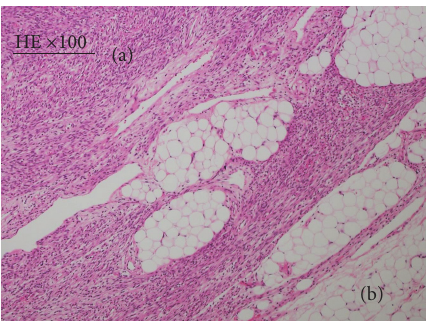
Figure 4: Hematoxylin and eosin (HE) staining findings in Case 2 ( × 100). (a) Plump to thin spindle cells with a low degree of cellular atypiaandlowmitoticactivitycanbeobserved.(b)Adiposecellscan be observed within the